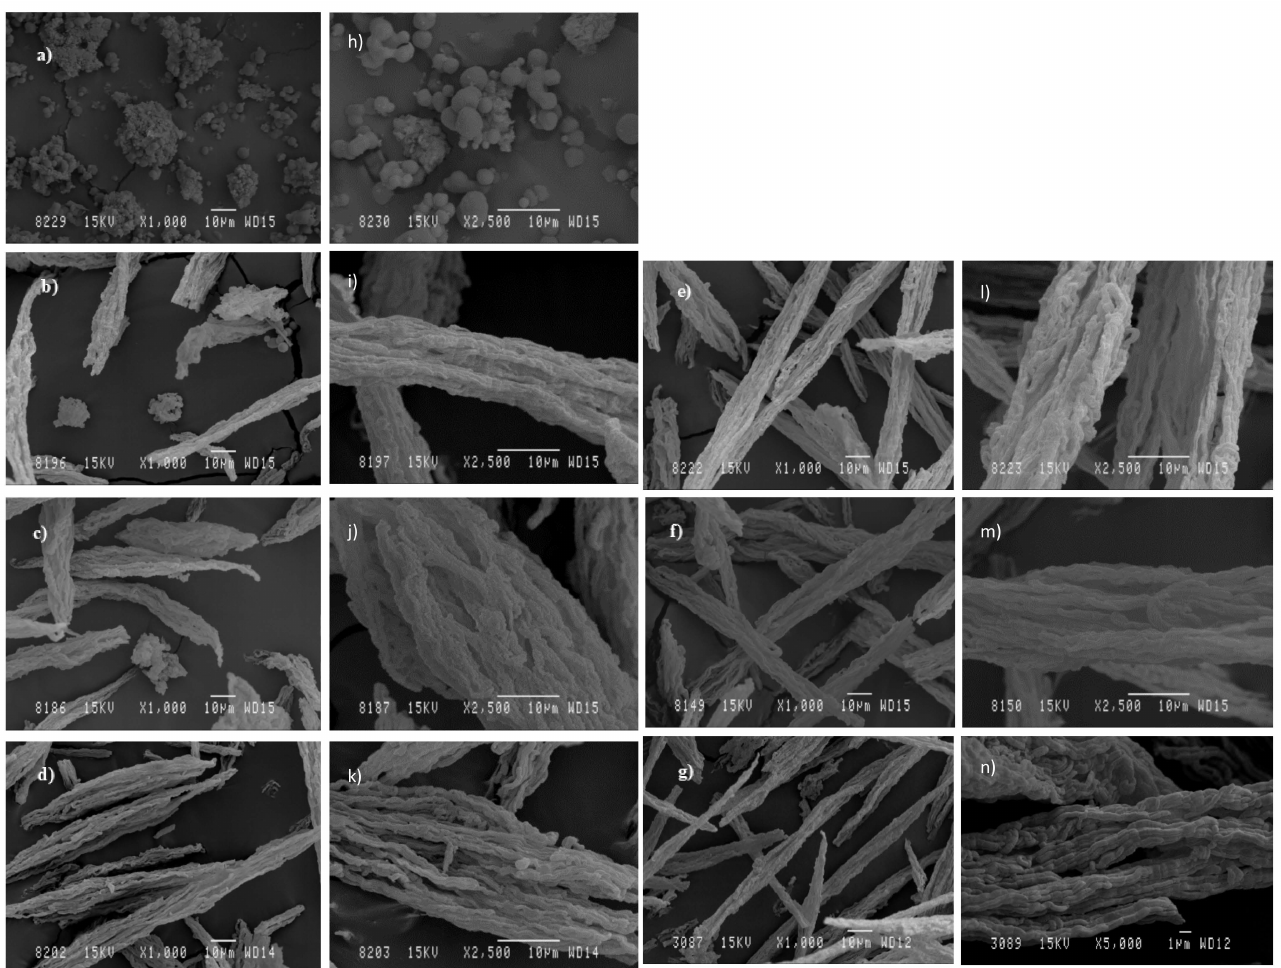
Figure 8. SEM images of the samples prepared at different reaction times and magnifications: ( a , h ) R1/3, ( b , i ) R2/3, ( c , j ) R1, ( d , k ) R2, ( e , l ) R4, ( f , m ) R6 and ( g , n ) R24 (Figure 1d,h